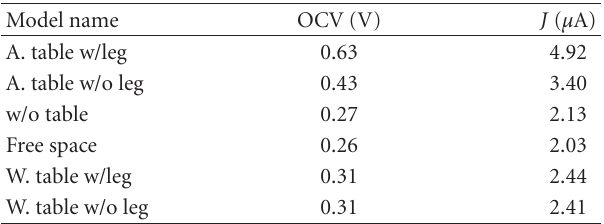
Table 4: OCV and current of the